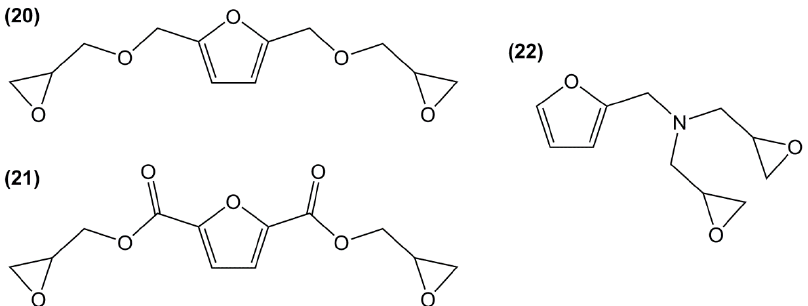
Figure 17. Furan-based diglycidylated compounds.